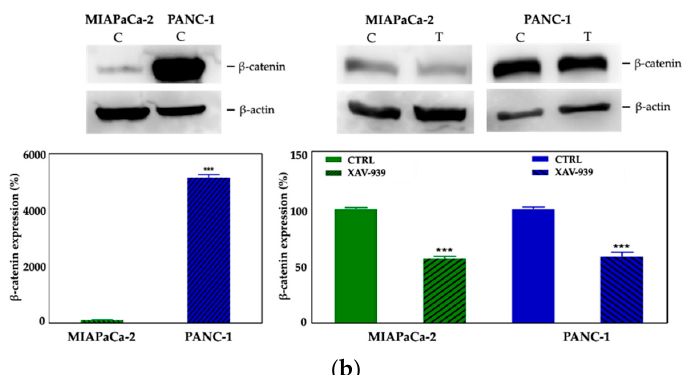
Figure 7. ( a ) Evaluation of β -catenin expression in PDAC cells treated with XAV-939 (10 µM) for 48 h by quantitative PCR (qPCR), * p -value < 0.05. ( b ) Evaluation of β -catenin expression in PDAC cells treated with 10 µM XAV-939 for 24 h by Western blotting and analysis of the bands by Image Lab software. C: control cells; T: 10 µM XAV-939 treated cells. β -actin was used to normalize protein expression levels. *** p -value < 0.001.